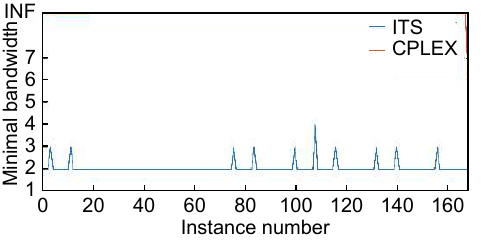
Fig. 8 Bandwidth comparison results of CPLEX and ITS solutions for 168 instances ( m = 4).